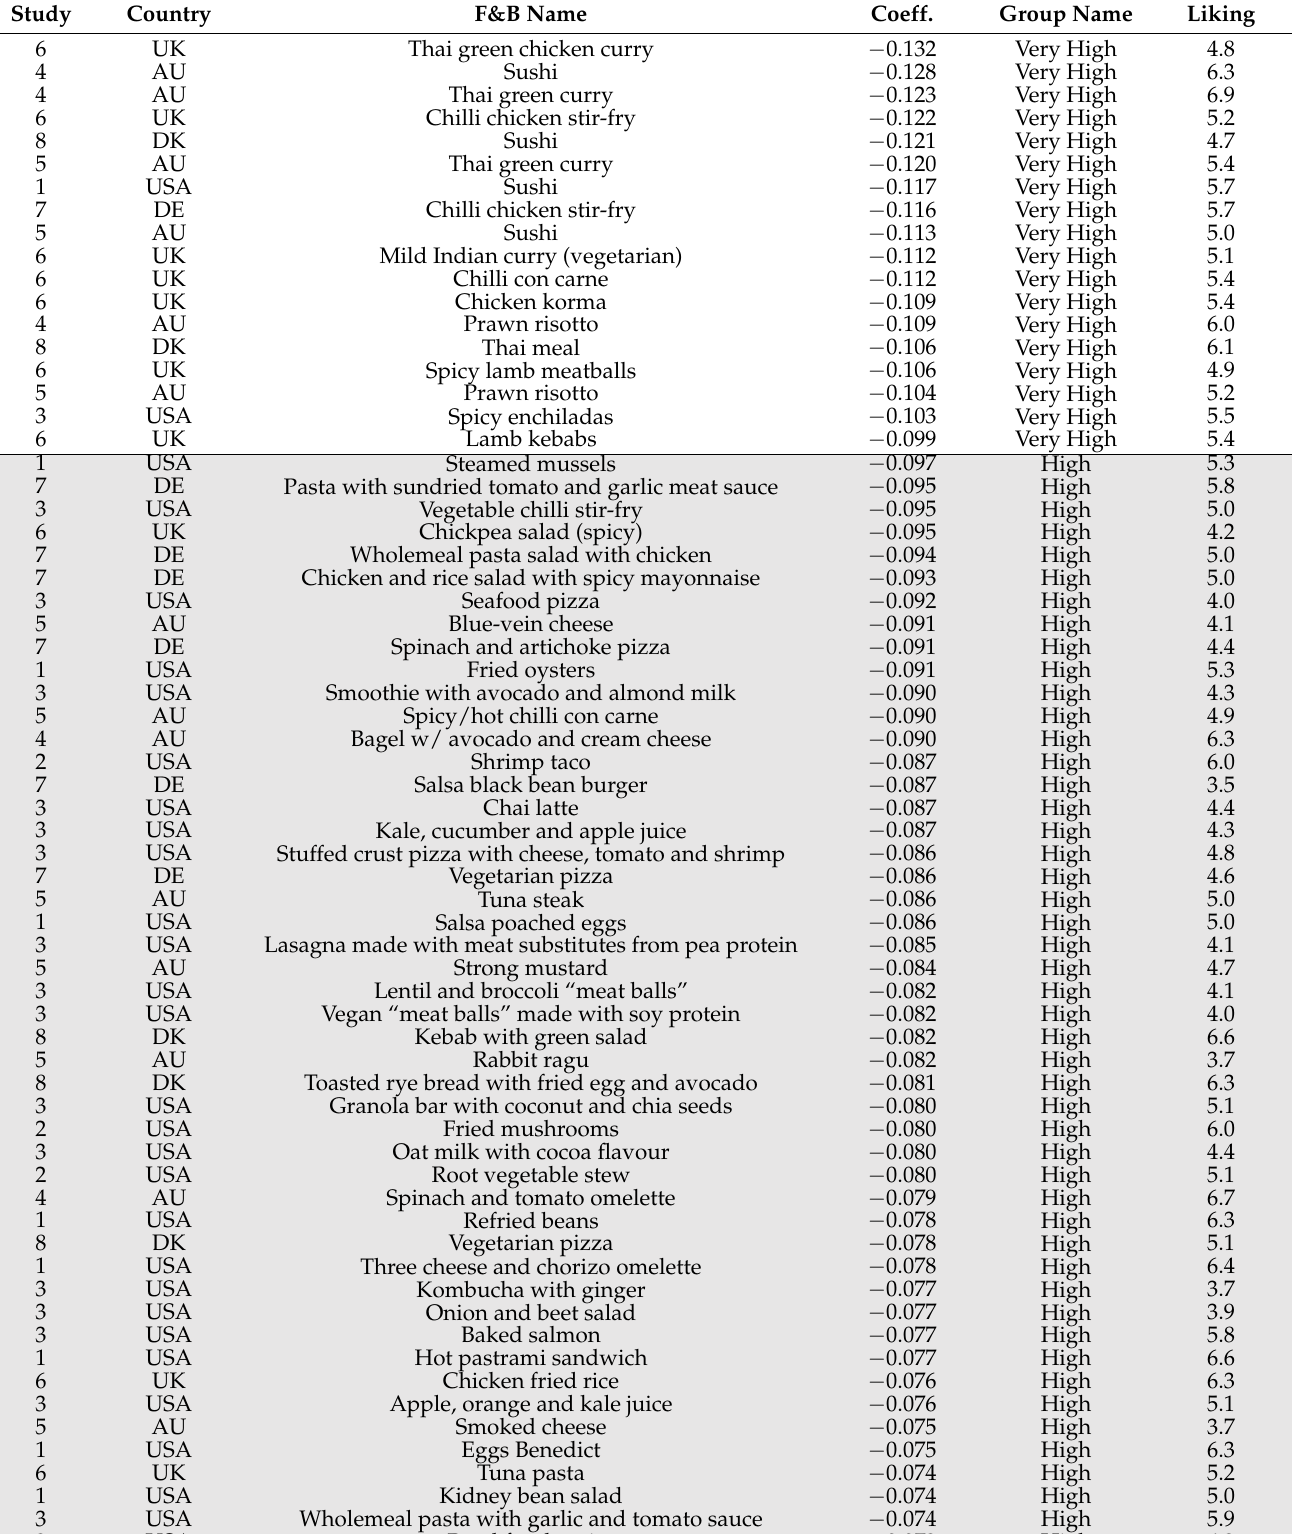
Table 2. Listing of F&B items (n = 197), sorted by group and regression coefficient (Coeff.) for effect of FN on liking/disliking. Names assigned to groups differentiate these on the level of negative effect of FN on F&B liking. For visual clarity, grey shading is used to differentiate groups. The final column shows average liking (1 = ‘dislike extremely’, 9 = ‘like